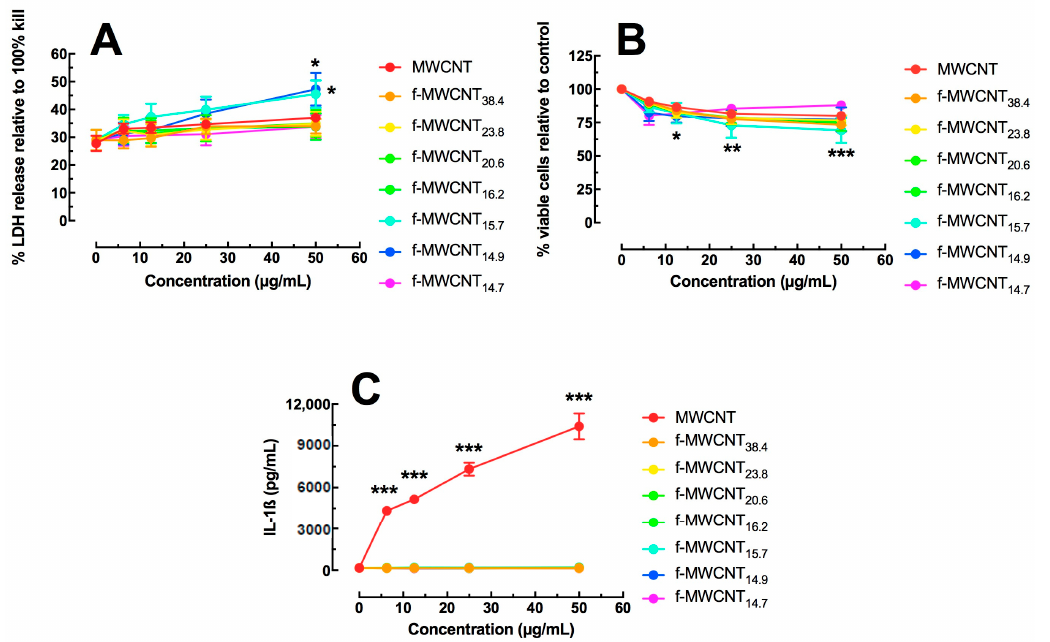
Figure 2. Effect of functionalized MWCNT on THP-1 macrophage-like cells in an in vitro 24 h culture. ( A ) Cell toxicity determined by LDH activity in cell media. Data expressed as mean LDH percent ± SEM compared to 100% cell death. ( B ) Cell toxicity determined by MTS assay. Data expressed as mean ± SEM viability relative to control cultures (0 μ g/mL). ( C ) IL-1 β release expressed as mean ± SEM pg/mL. Asterisks *** indicate p < 0.001, ** p < 0.01, or * p < 0.05 compared to 0 μ g/mL concentration.